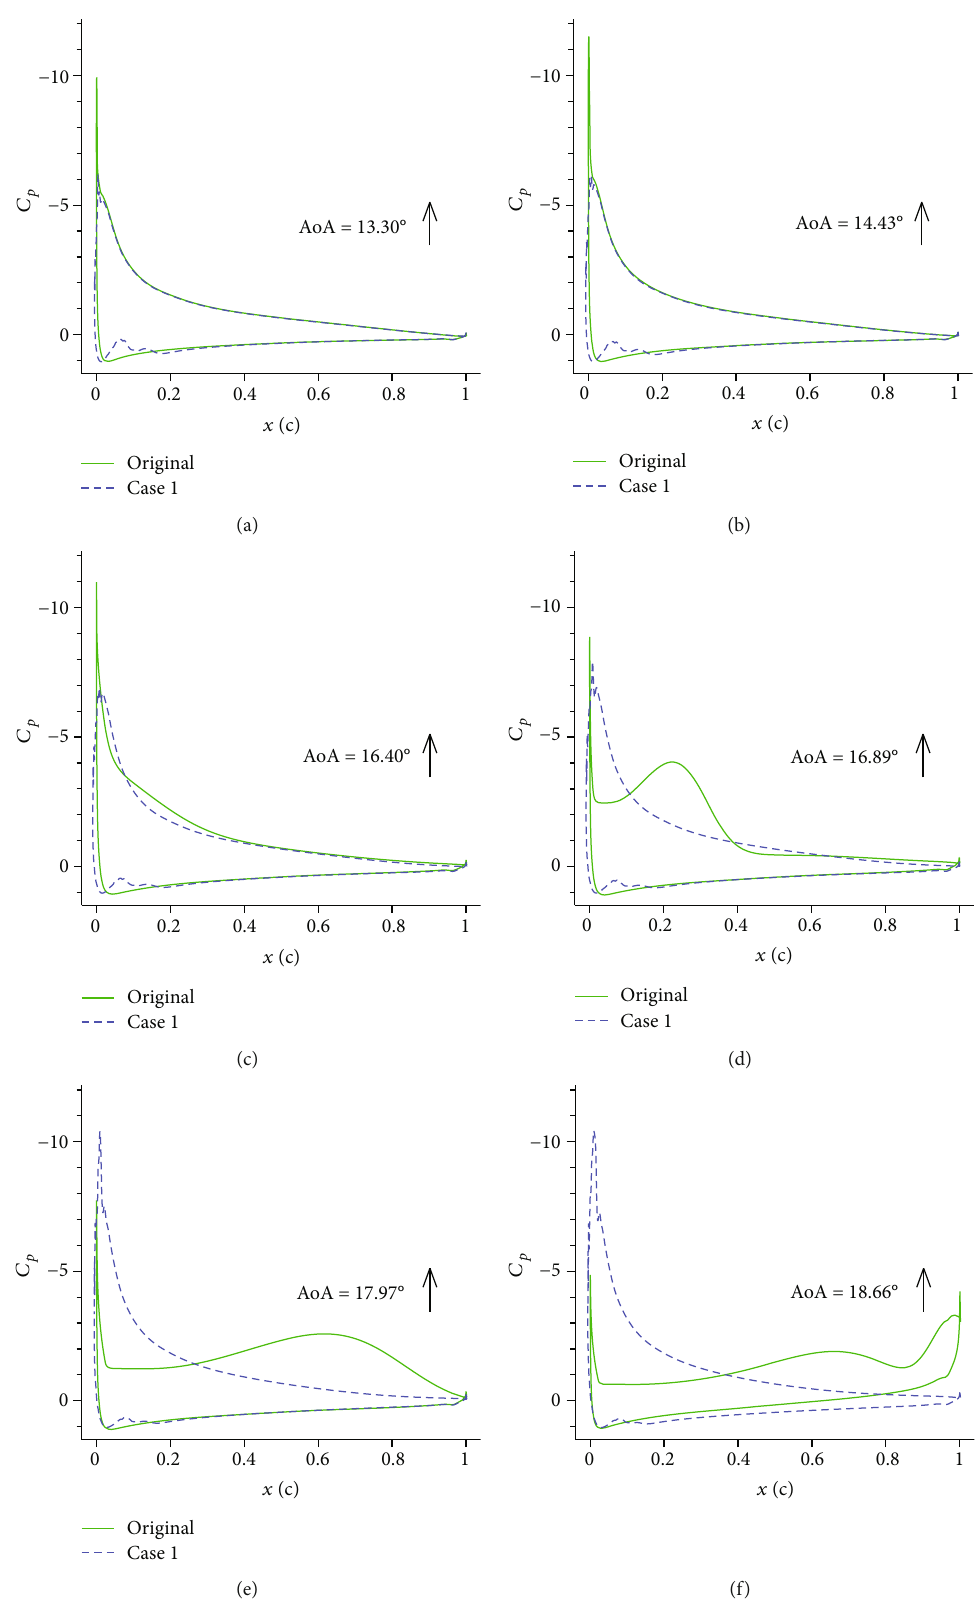
Figure 15: Pressure distributions on the airfoil surface at di ff erent angles of